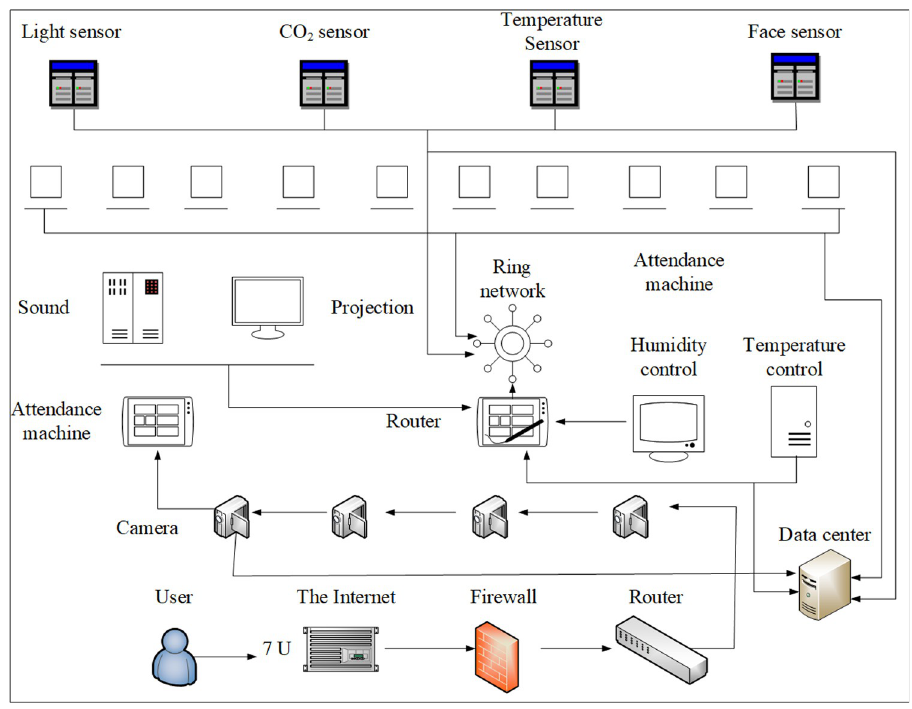
Fig 5. The overall structure of smart classroom.